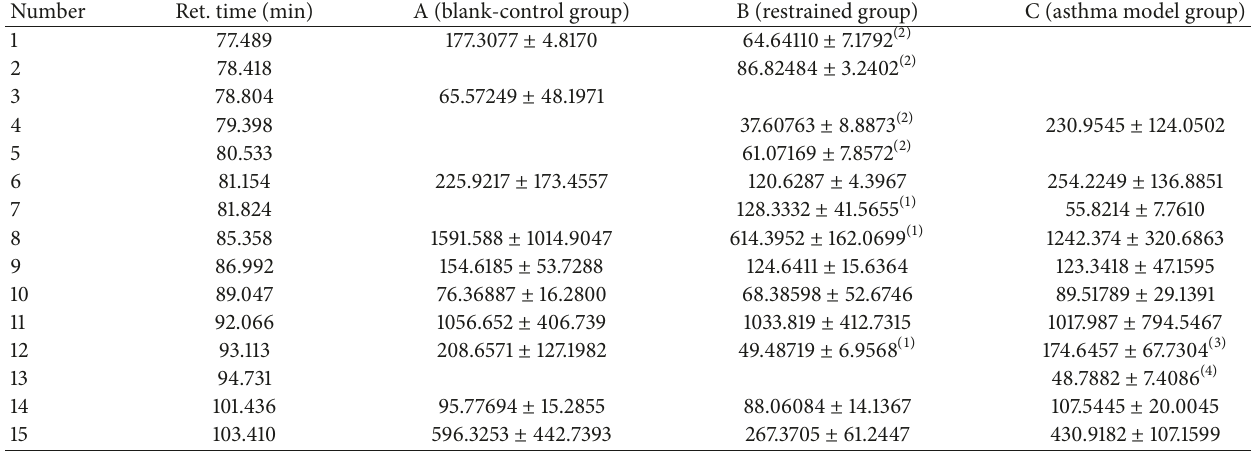
Table 1: Areas of serum peptide peaks comparison in 3 groups (mean ± SD).